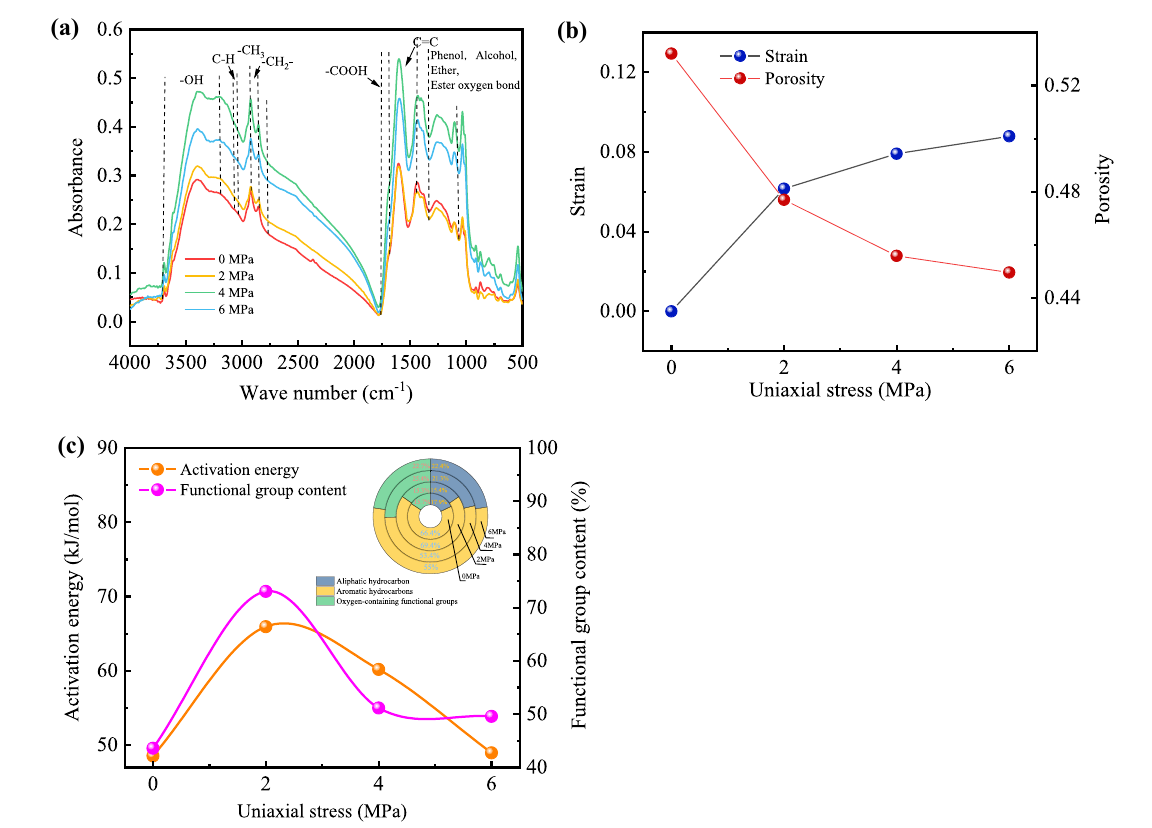
Fig. 3 Microstructure changes under different uniaxial stresses a Infrared spectra of pre-processed coal samples; b Stress–strain and stress–pore curves; c Changes in apparent activation energy and group